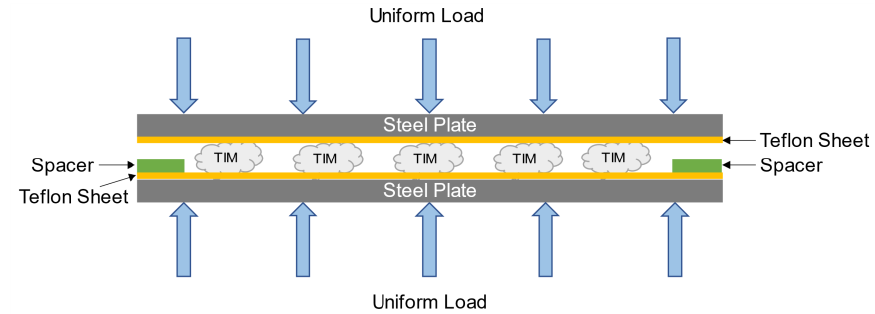
Figure 2. Schematic of TIM sample preparation assembly.